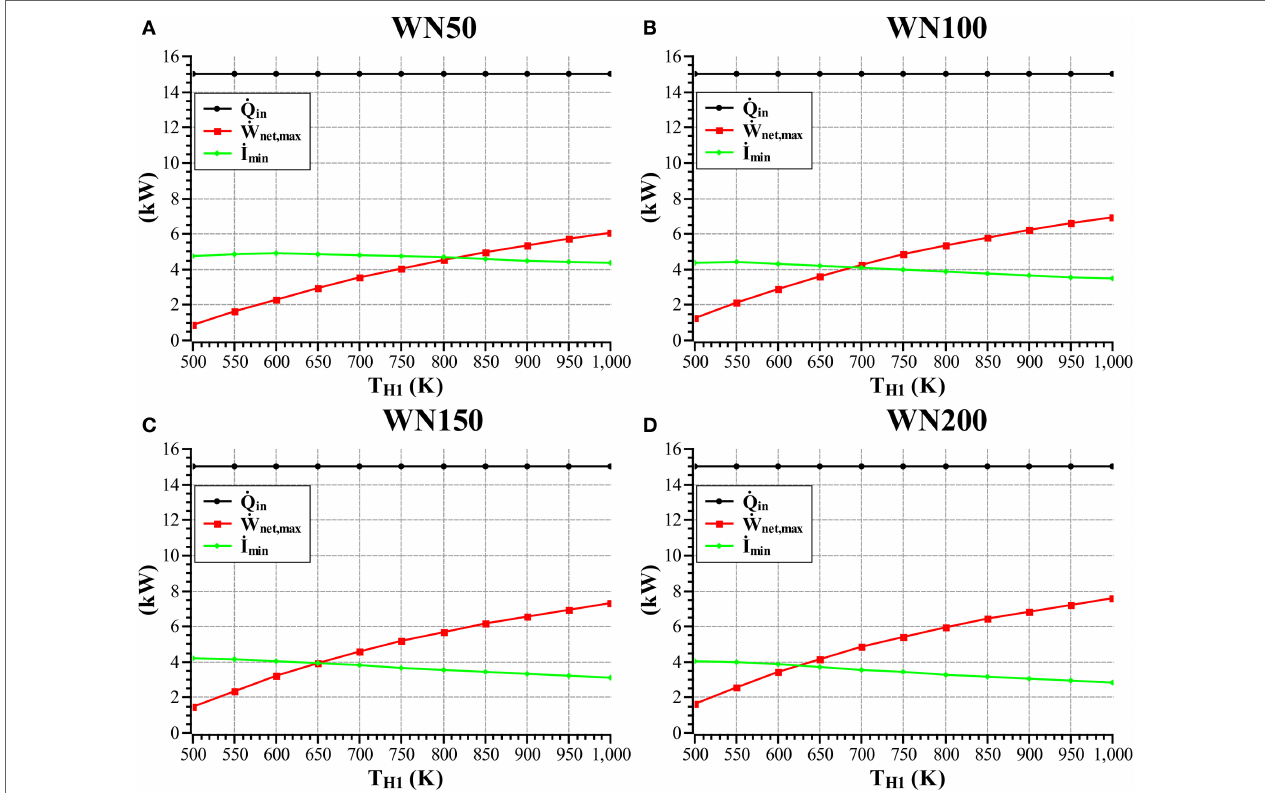
Figure 3 is a plot of the maximum net-work output, minimum total irreversibility rate, and absorbed energy versus heater inlet temperature for the four different mesh types.